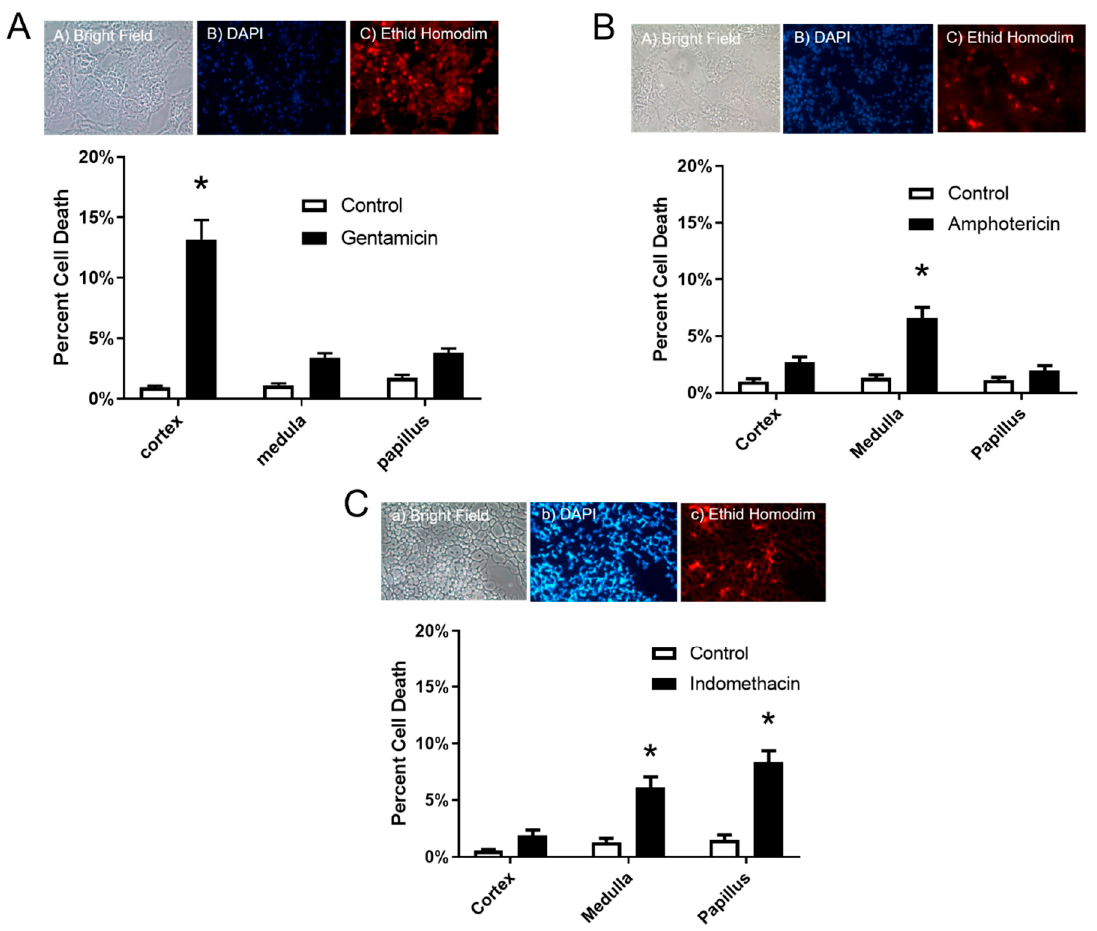
Figure 2. Effects of various site specific nephrotoxicants on cell membrane permeability in the renal cortex, medulla and papilla. Male Sprague/Dawley rats were treated with a proximal tubule/cortex nephrotoxicant (gentamicin 100 mg/Kg/day i.p. for 8 days) a distal tubule/medulla toxicant (amphotericin B 15 mg/Kg/day i.p. for 5 days) and collecting duct/papilla nephrotoxicant (indomethacin single dose 20 mg/Kg p.o.). Control animals were treated similarly with vehicle alone (saline). Data show percent ethidium homodimer labeled (dead) cells in the cortex, medulla and papilla for ( A ) gentamicin, ( B ) amphotericin B, and ( C ) indomethacin. Figure insert shows